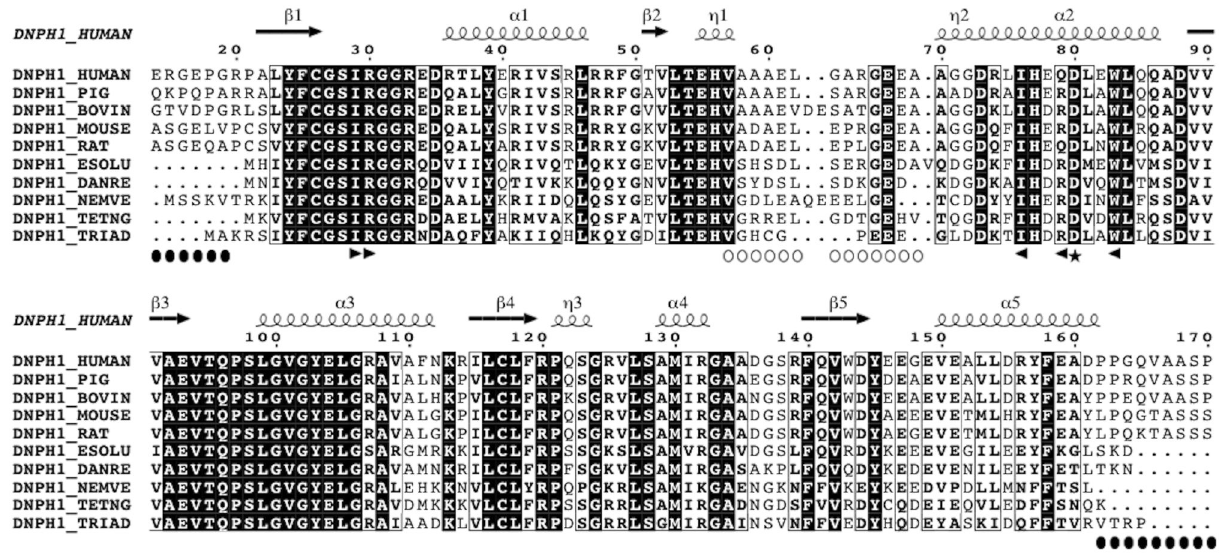
1. Sequence alignment of animal DNPH1s. Sequences of DNPH1 enzymes from various species (ranging from human to fish) have been refined using ViTO (39) to take into account the known crystal structures of the rat DNPH1. Secondary structures are shown above the sequence alignment. Sequence numbering corresponds to the rat sequence. Black circles underline the regions deleted in the crystallized recombinant enzyme. Open circles underline the long flexible loop surrounding the nucleotide binding site. Black arrows indicate the position of the residues (I18’, R19’, F64’, I65’, Q68) whose side chains interact with the N 6 - substituents in the solved crystal structures. The figure was generated by ESPRIPT (40). doi: